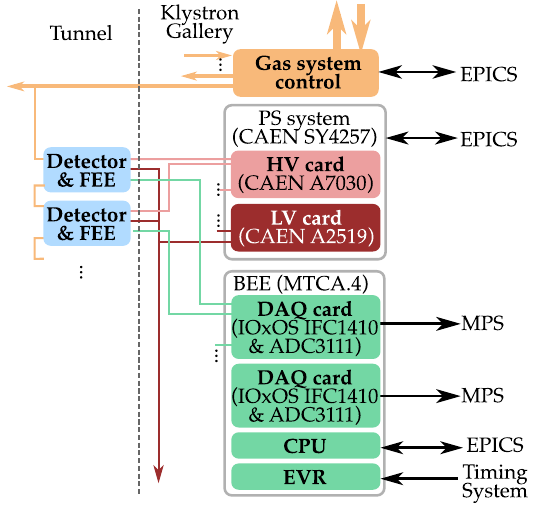
FIG. 3. Schematic view of the nBLM system architecture consisting of detector modules (detectors with front-end elec- tronics — FEE), back-end electronics (BEE) for data acquisition (DAQ), gas system, power supply (PS) system providing high (HV) and low (LV) voltage to detector modules and EPICS-based [22] control system. The system connects to the ESS machine protection (MPS [20]) and ESS timing [21]